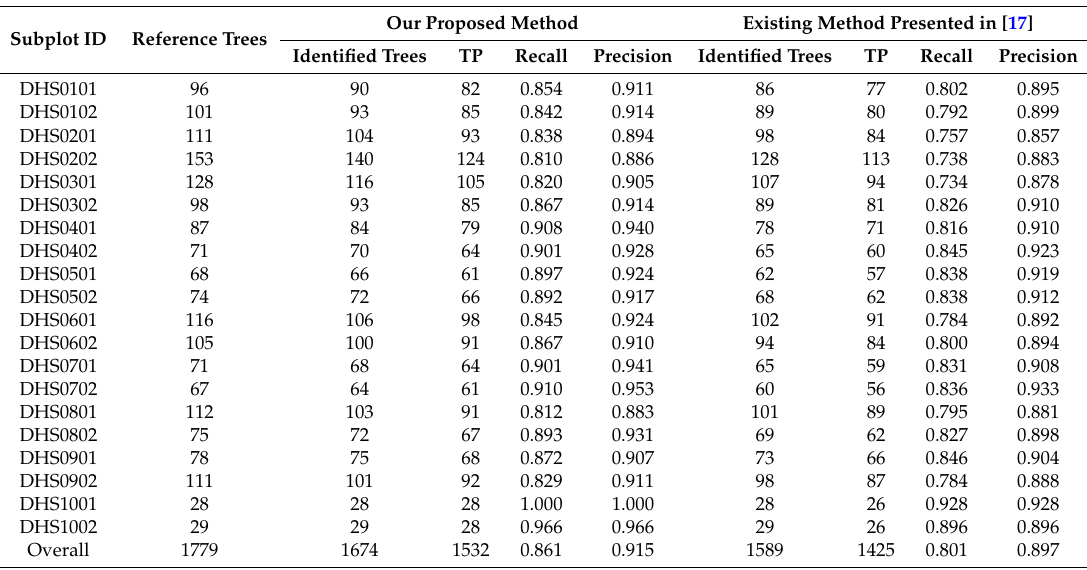
Table 4. Detection result comparison of mean shift-based approaches for all trees in 20 test subplots: our proposed adaptive mean shift algorithm vs. the existing one proposed in [17].